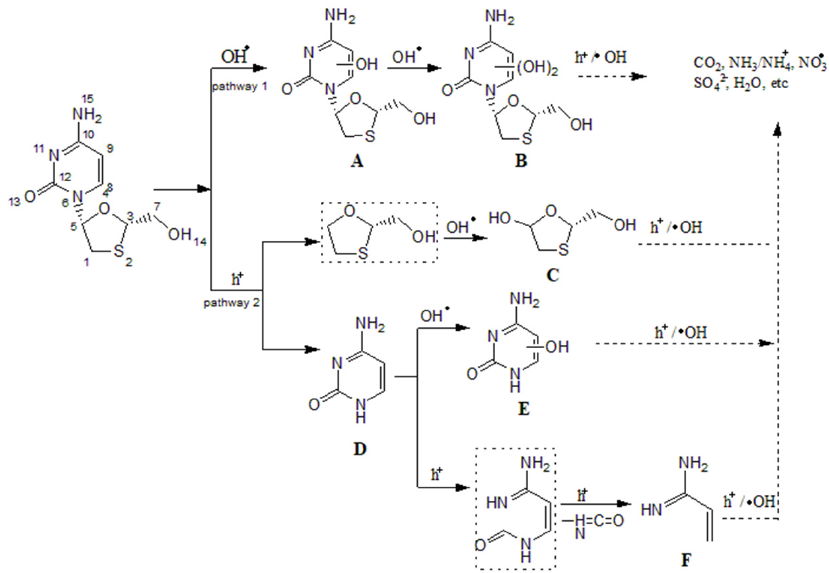
Scheme 5. Proposed photocatalytic degradation mechanism of lamivudine by TiO 2 . Reprinted from Thi L-AP. et al., 2021 with permission from Nanostructured Photocatalysts, 2021. Copyright © 2021 Elsevier B.V., Amsterdam, The Netherlands